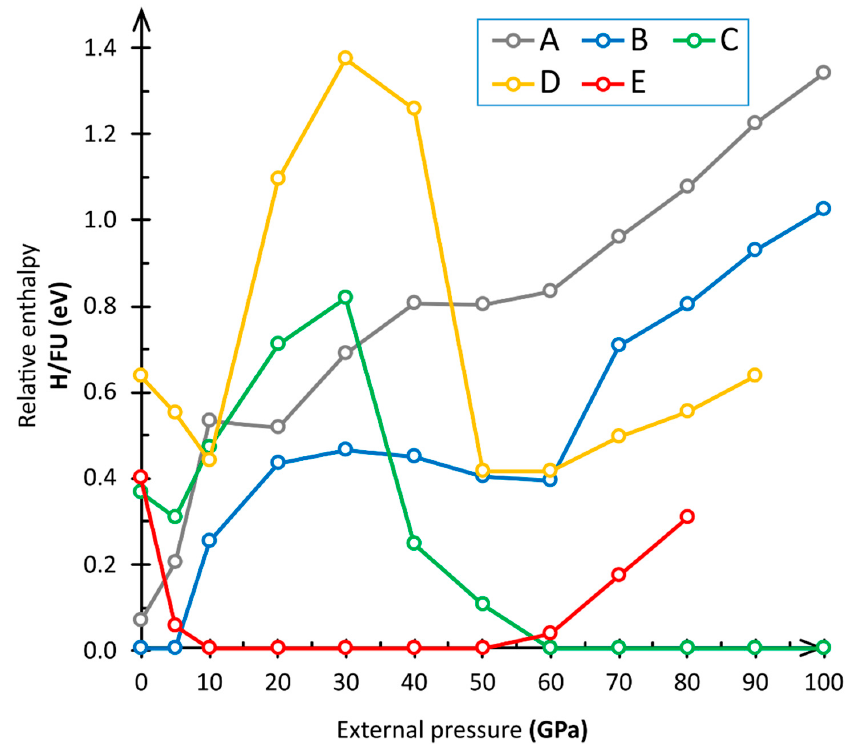
Figure 2. Relative enthalpy of five important polymorphs of K 2 AgF 4 in the 0–100 GPa pressure range. Enthalpy of the most stable polymorph at any given pressure is taken as reference (0 eV) at that pressure.